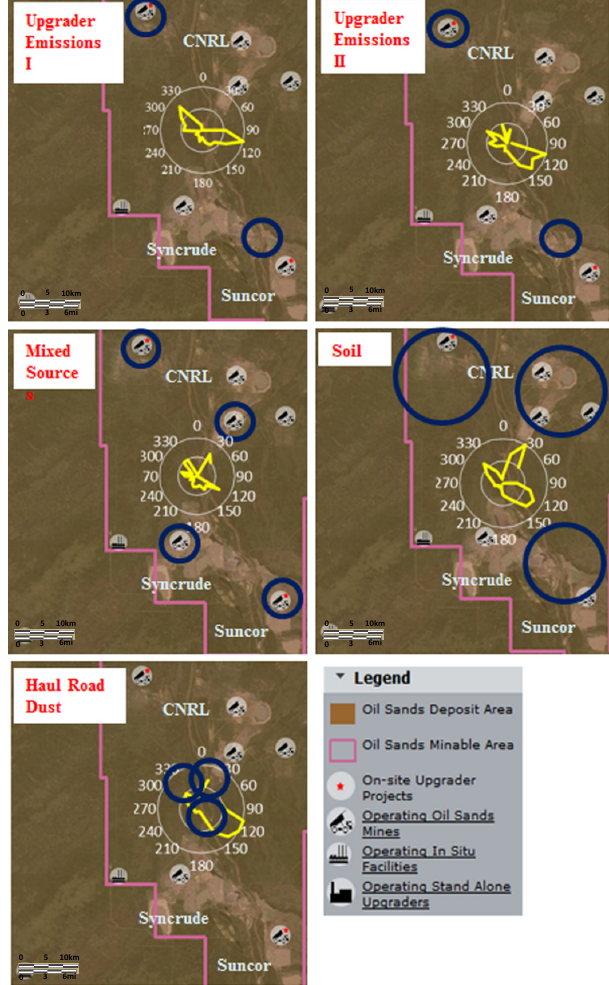
Figure 7. CPF profiles of the 5 factors identified by hourly Xact data during the intensive campaign in August 2013. Blue circles indicate possible source locations. Map courtesy of Alberta: Environmental and Sustainable Resource Development. Available: http://osip.alberta.ca/map/ .